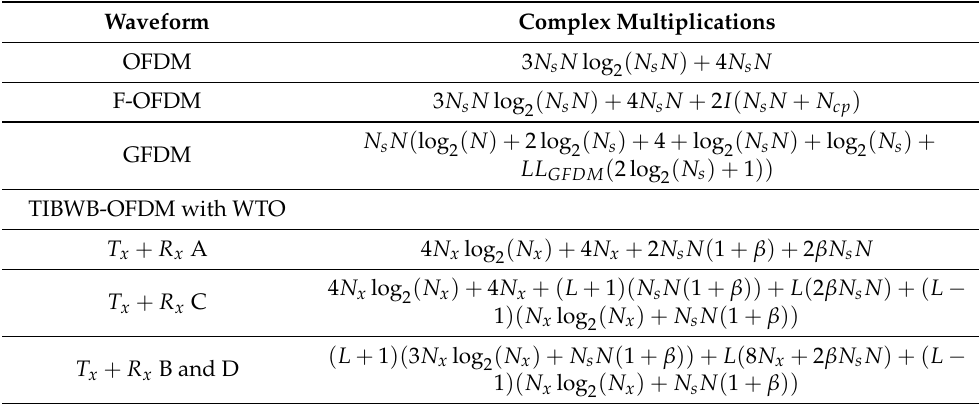
Table 2. Transceiver complexity for the different